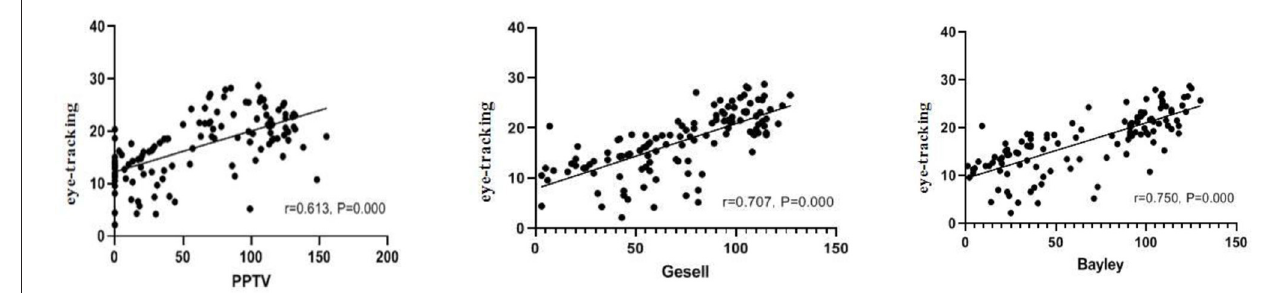
FIGURE 3 | Correlation between PPVT, Gesell, Bayley, and eye-tracking technology.